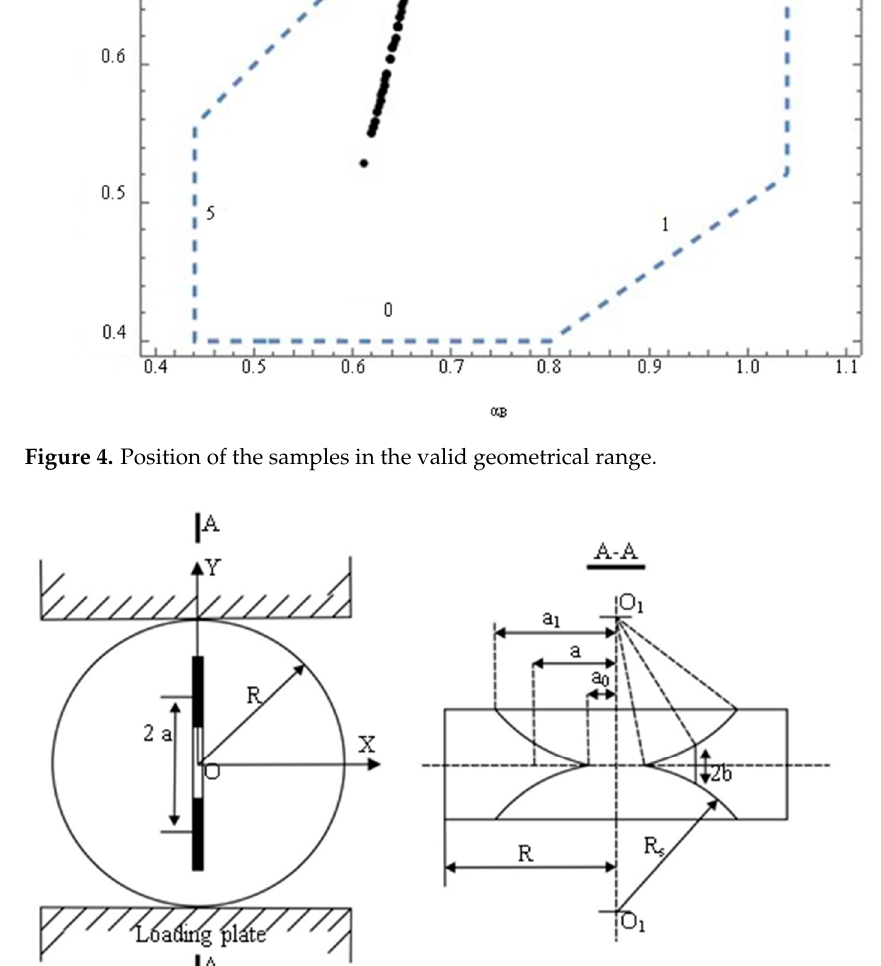
Figure 6. Wideness of the chevron crack ( A ), cross-section of the chevron notch ( B ), loading mode-I before failure ( C ), and loading mode-I after failure ( D ).